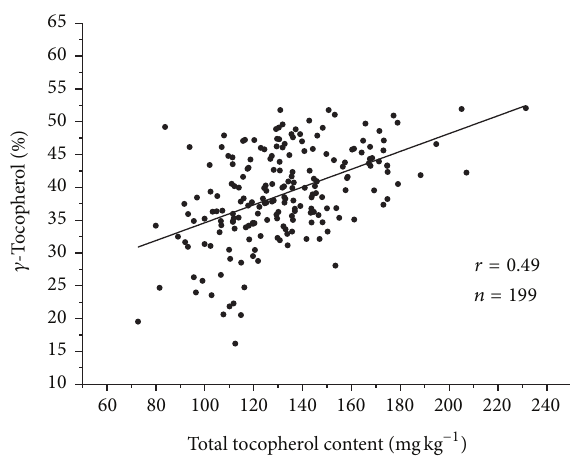
Figure 3: Scatter plot of total seed tocopherol content (mgkg −1 seed) and concentration of 𝛾 -tocopherol (% total tocopherols) in a population of 199 F 2 plants from the cross between the Ethiopian mustard lines BCT-6, with reduced 𝛾 -tocopherol content, and C-101, with conventional levels of 𝛾